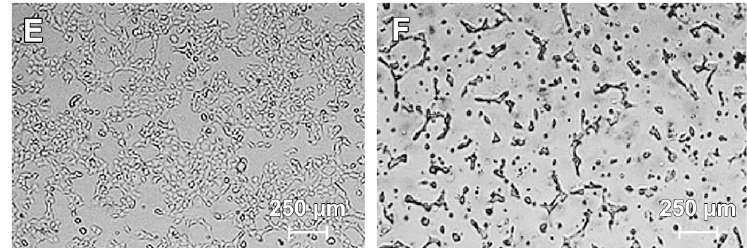
Figure 2. Lomefloxacin induces morphological changes in COLO829 melanoma cells: control COLO829 cells incubated for ( A ) 24 h, ( C ) 48 h, and ( E ) 72 h; cells exposed to lomefloxacin at a concentration of 1.0 mmol/L for ( B ) 24 h, ( D ) 48 h, ( F ) and 72 h. The cells were observed under a light inverted microscope at 40× magnification (scale bar 250 µm).